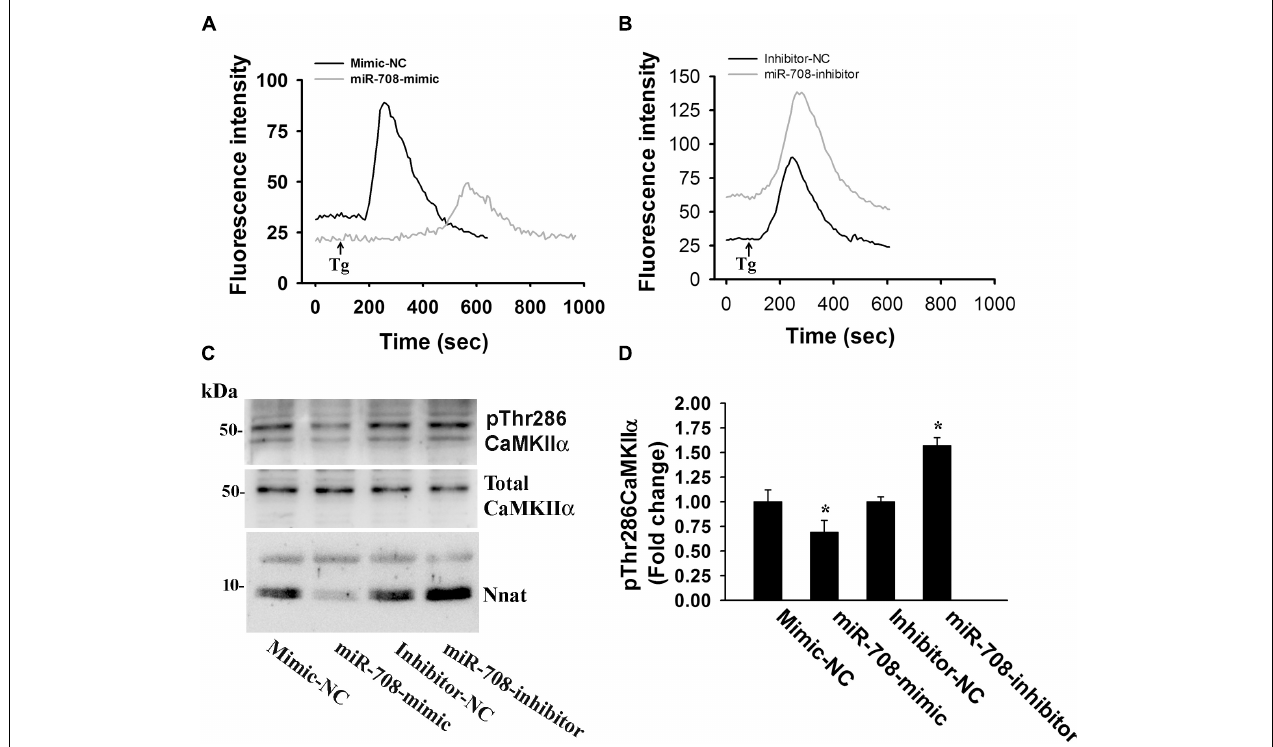
FIGURE 5 | miR-708 regulates intracellular Ca 2 + level and altered the phosphorylation of CAMKII α at Thr286. Representative Ca 2 + traces of neuro 2a cells transiently transfected with either miR-708 mimic (A) or miR-708 inhibitor (B) in the absence or presence of thapsigargin (Tg). Twenty four hours of post-transfection, cells were subjected to Ca 2 + imaging using Fluo-4 AM dye. Thapsigargin (100 µ M) was added after 100 sec of baseline recording. Approximately 50–60 cells were randomly selected in each experimental group for measuring fluorescence intensity and the experiment was repeated twice. (C) Immunoblot analysis of total and Thr286 phosphorylated form of CaMKII α in miR-708 mimic or its inhibitor transfected neuro 2a cell lysates. (D) Quantitative evaluation of the band intensity of Thr286 phosphorylated form of CaMKII α in the experiment shown in (C) . Data was normalized against total CaMKII α . Values are mean ± SD of three independent experiments. ∗ P < 0.01 compared to respective control